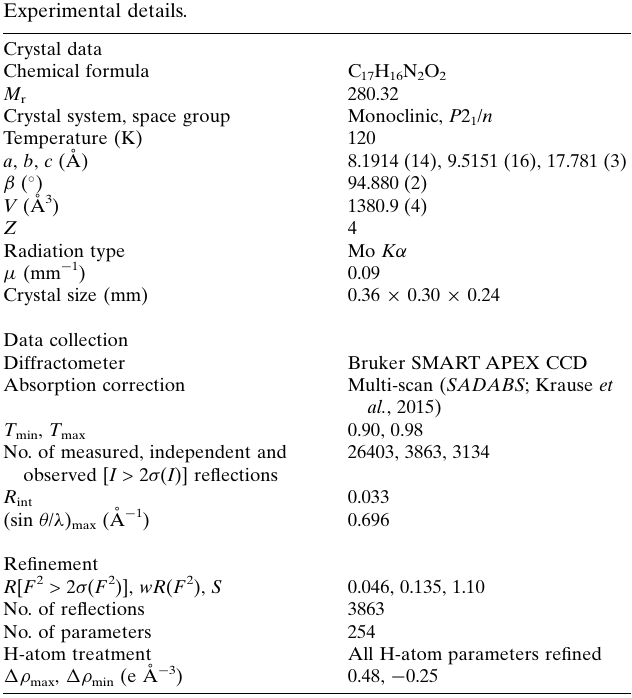
Table 2 Experimental